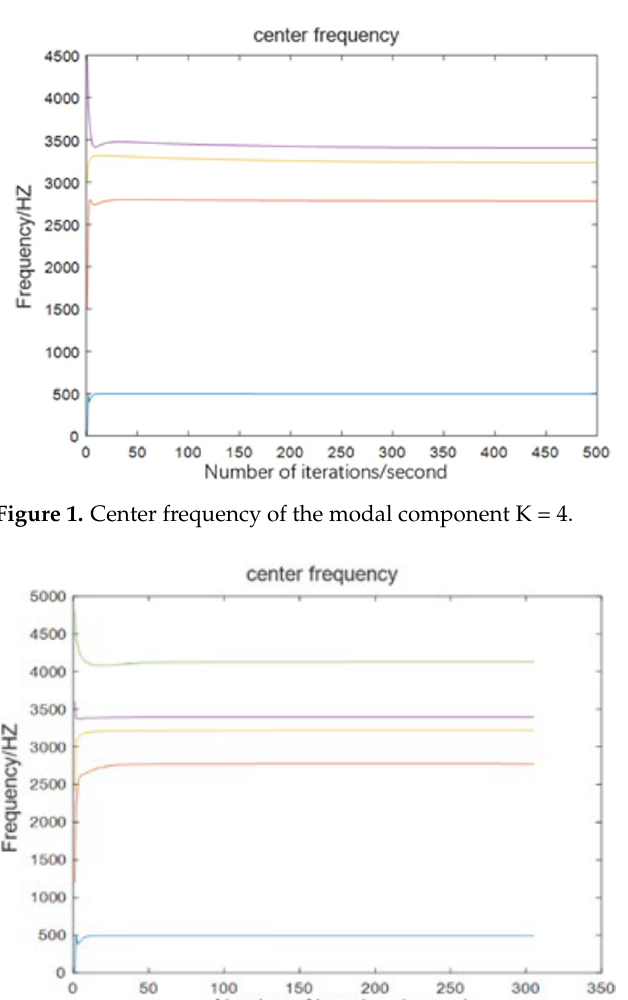
Figure 3. Center frequency of the modal component K = 6. From the calculation formulas of multi-scale dispersion entropy and composite multi-scale dispersion entropy, it can be seen that five parameters need to be selected. They are the length N of the sequence, the embedding dimension m, the number of cate- gories c, the time delay d and the scale factor τ. In this paper, the length n = 1024, the embedding dimension m = 3, the number of categories c = 6, the time delay d = 1, and the scale factor are selected through simulation analysis. Figures 4–6 show a random point entropy curve corresponding to scale factors 8, 10, and 12, respectively.